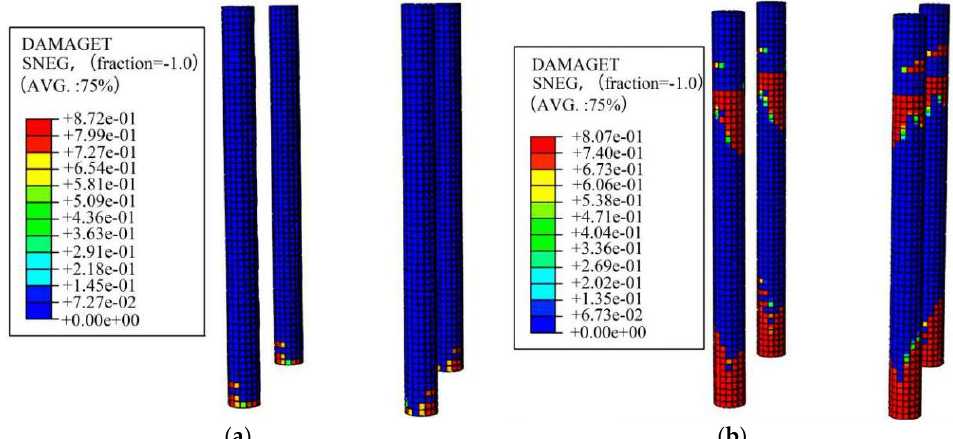
Figure 10. Numerical results of tensile damage patterns of tubular columns: ( a ) At the end of loading case with PGA (peak ground acceleration) of 0.20 g; ( b ) At the end of loading case with PGA of 0.60 g.